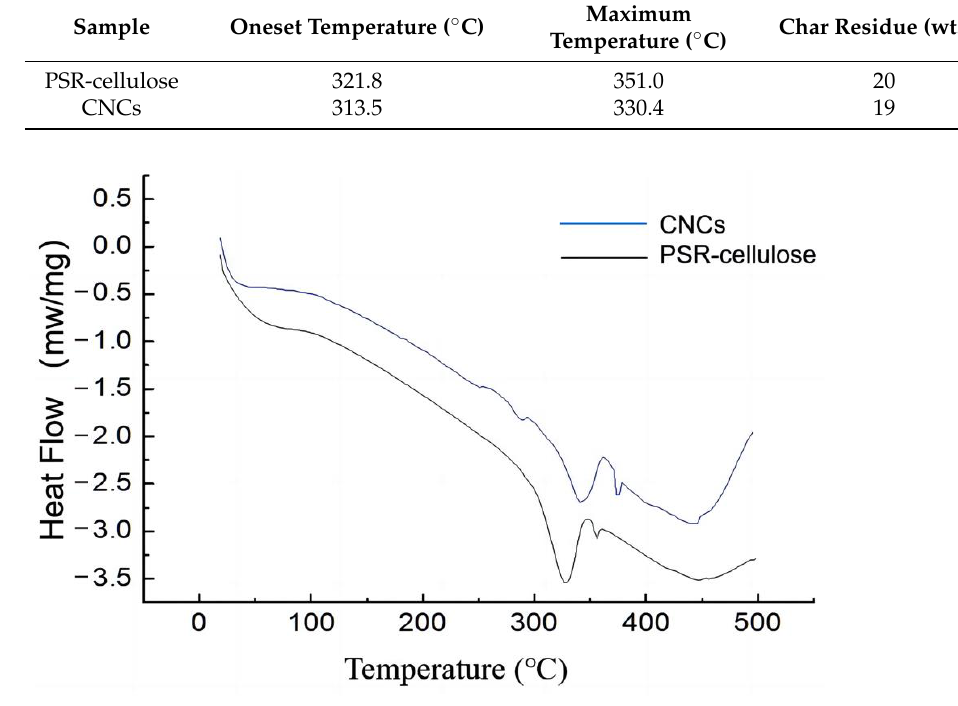
Figure 6. DSC profiles of PSR-Cellulose and CNCs. Table 7. Thermal parameters of Pennisetum Sinese Roxb and CNCs obtained from DSC analysis.